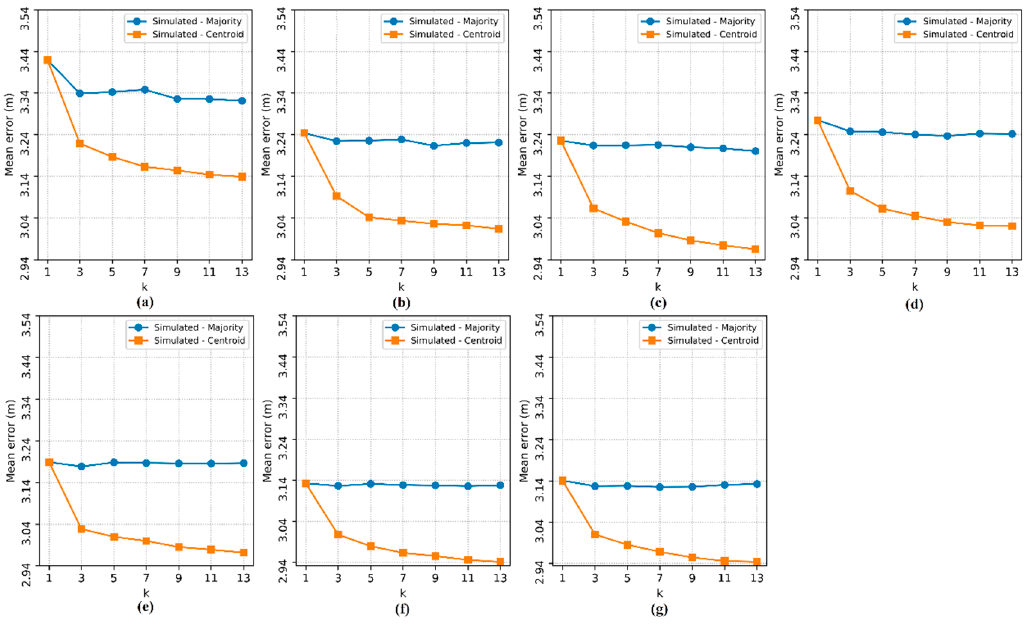
Figure 13. Localization mean error in the simulated environment with an area of 28 m × 28 m. The subfigures show the tests for each number of access points: ( a ) 2 APs, ( b ) 3 APs, ( c ) 4 APs, ( d ) 5 APs, ( e ) 6 APs, ( f ) 7 APs and ( g ) 8 APs.